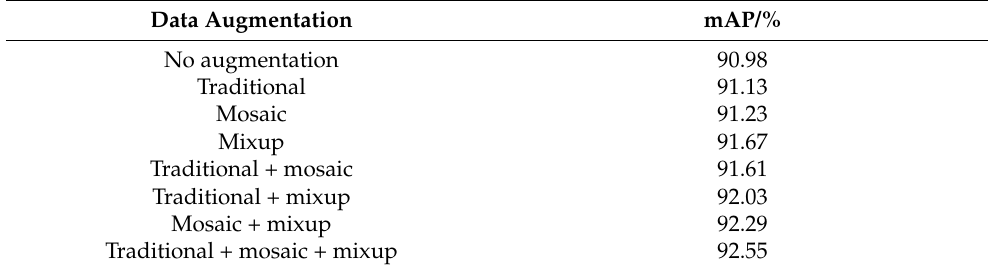
Table 2. The result of data